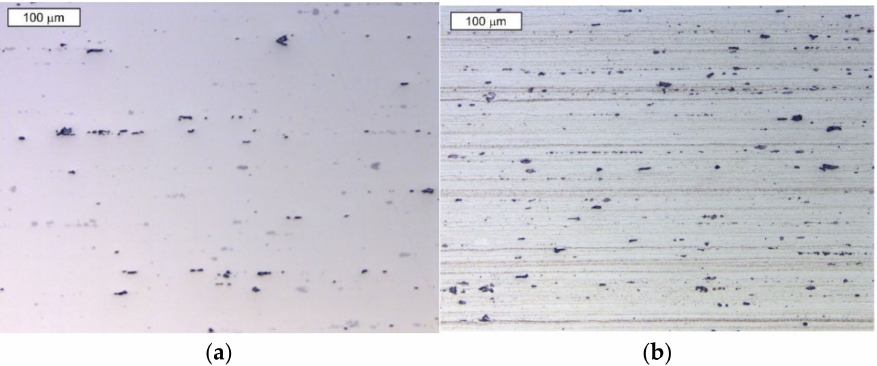
Figure 7. Microstructure of the alloy in the DA state: ( a ) unetched state and ( b ) etched state. Light microscopy, BF.